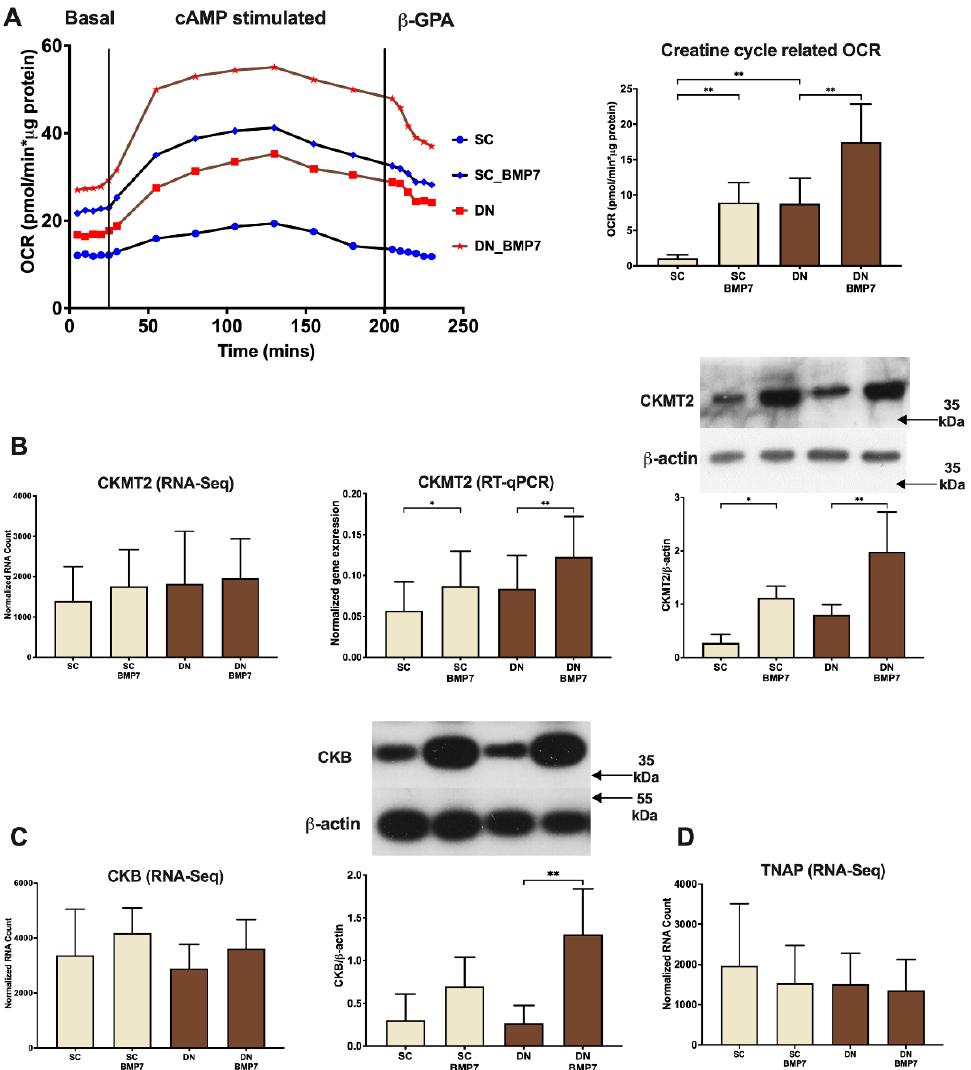
Figure 6. BMP7 treatment upregulated creatine futile cycle-mediated thermogenesis in SC and DN derived differentiated adipocytes. SC and DN preadipocytes were differentiated and treated as in Figures 1–5. ( A ) Representative time lapse OCR curve after indicated treatments, followed by quantification of creatine cycle related ( β -GPA inhibited) OCR ( n = 5). ( B ) Quantification of gene expression of CKMT2 by RNA-sequencing ( n = 9) and RT-qPCR ( n = 5), followed by protein expression ( n = 5). ( C ) Quantification of gene expression of CKB by RNA-sequencing ( n = 9), followed by protein expression ( n = 4). ( D ) Quantification of gene expression of TNAP by RNA-sequencing ( n = 9). Data expressed as mean ± SD. RT-qPCR was normalized to GAPDH, protein expression was normalized to β -actin. * p < 0.05, ** p < 0.01. Statistics: one-way ANOVA with Tukey’s post-test.